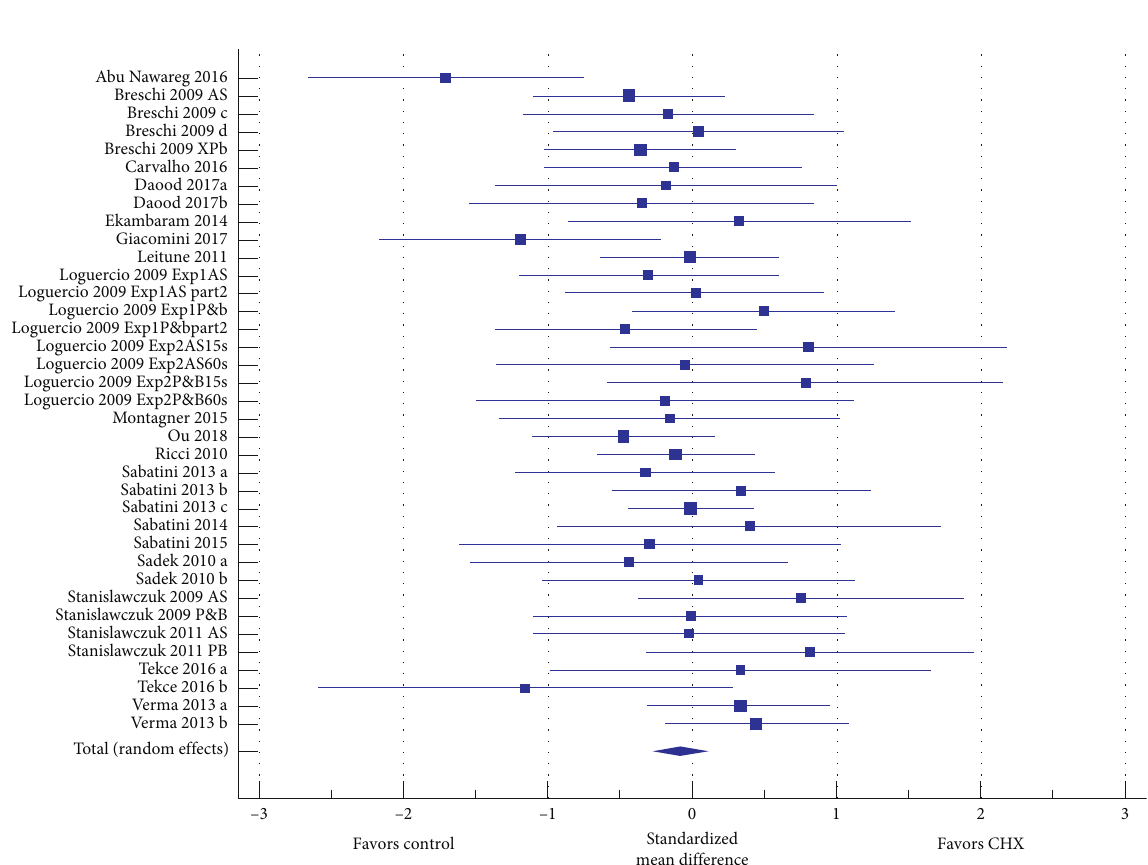
Figure 2: Forest plot of studies at baseline. The N for both groups was 396 samples. The total random effect standardized mean difference (SMD) was − 0.0821 (CI 95% − 0.240; 0.076). The difference was not statistically significant ( t � − 1.019, P � 0 . 308). The I 2 (inconsistency) was